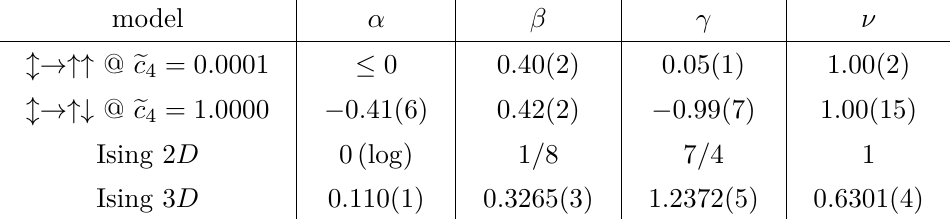
c = 0 . 01 , l + ↑↓→↑↑ transition is 1st order and both C and χ 4 e